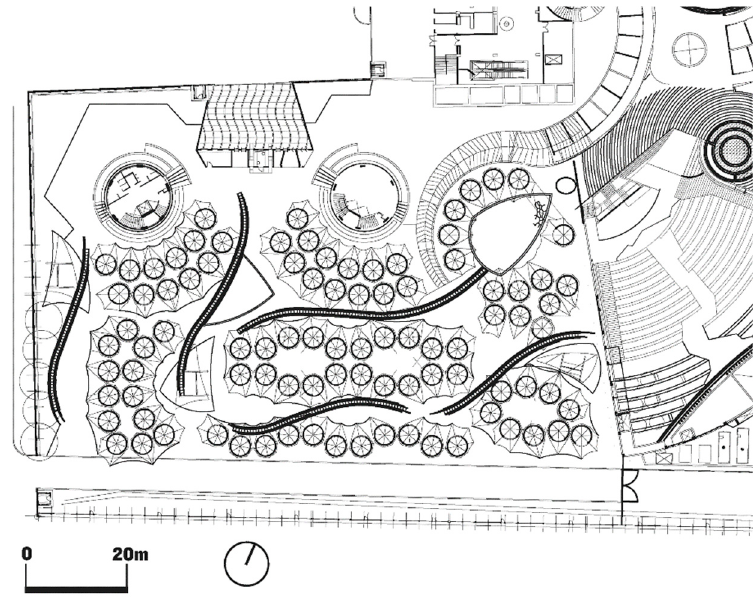
Figure 33. Floor plan of the informal zone having craft shops (Courtesy: Archohm Consults).